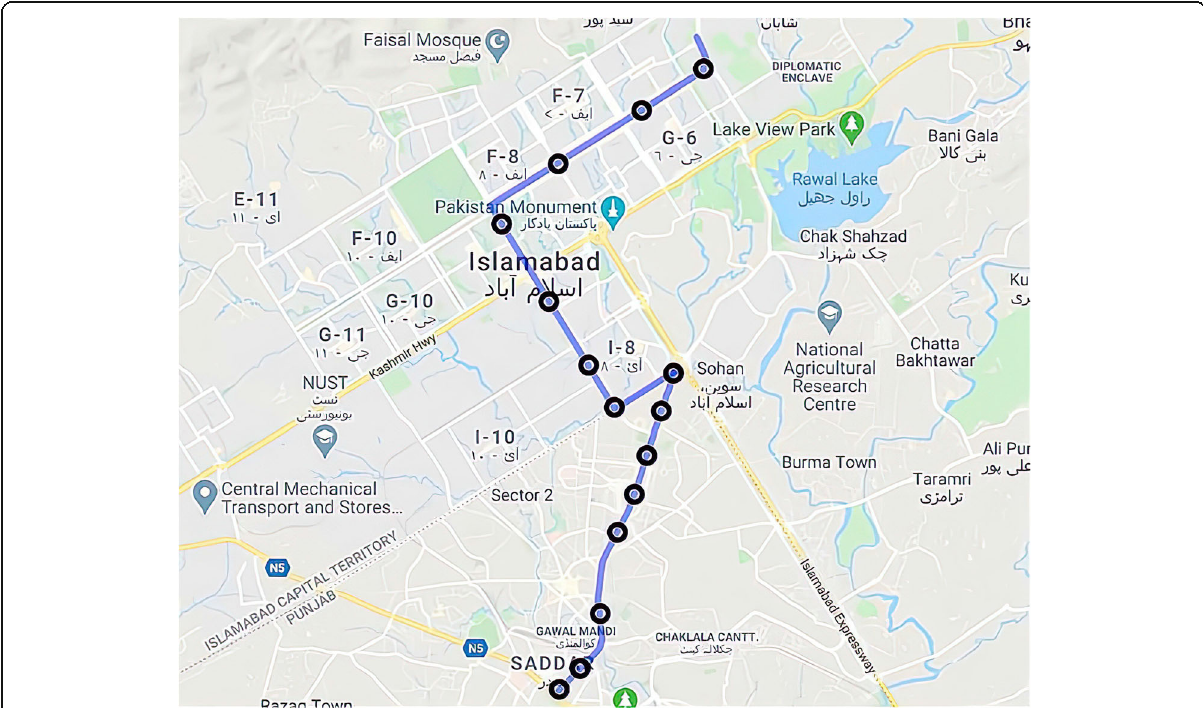
Fig. 2 Data collection points (Rawalpindi-Islamabad METRO